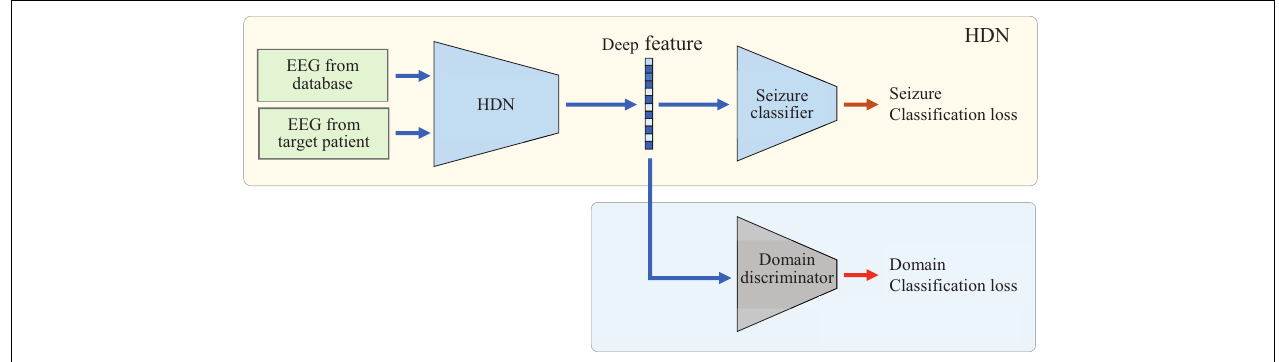
FIGURE 2 | Domain adaptation of the proposed HDN based on adversarial